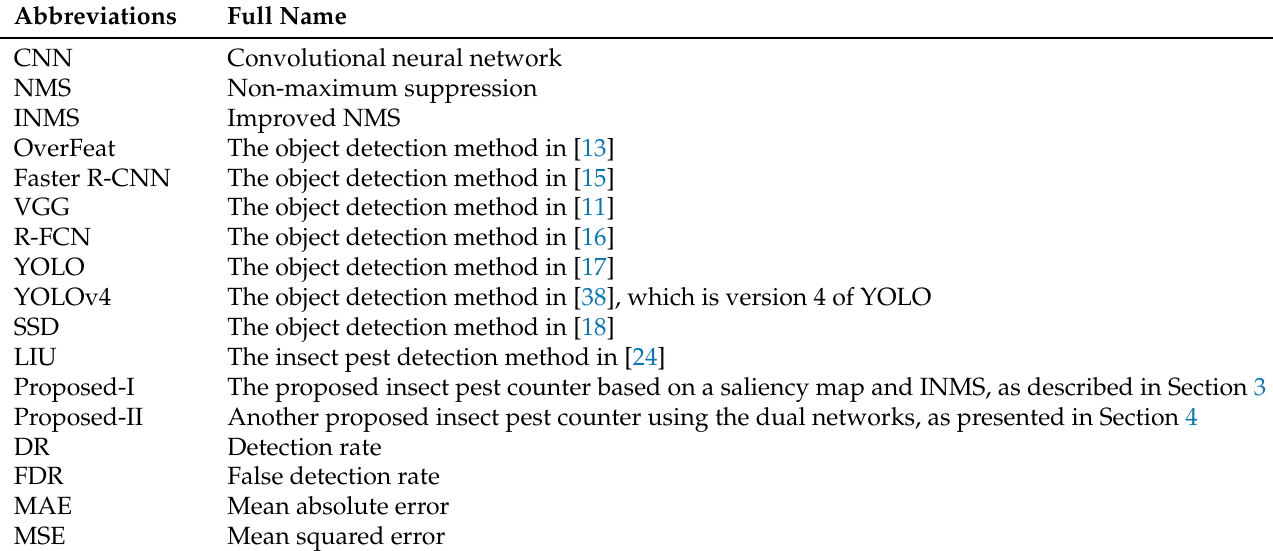
Table 1. Main abbreviations in the